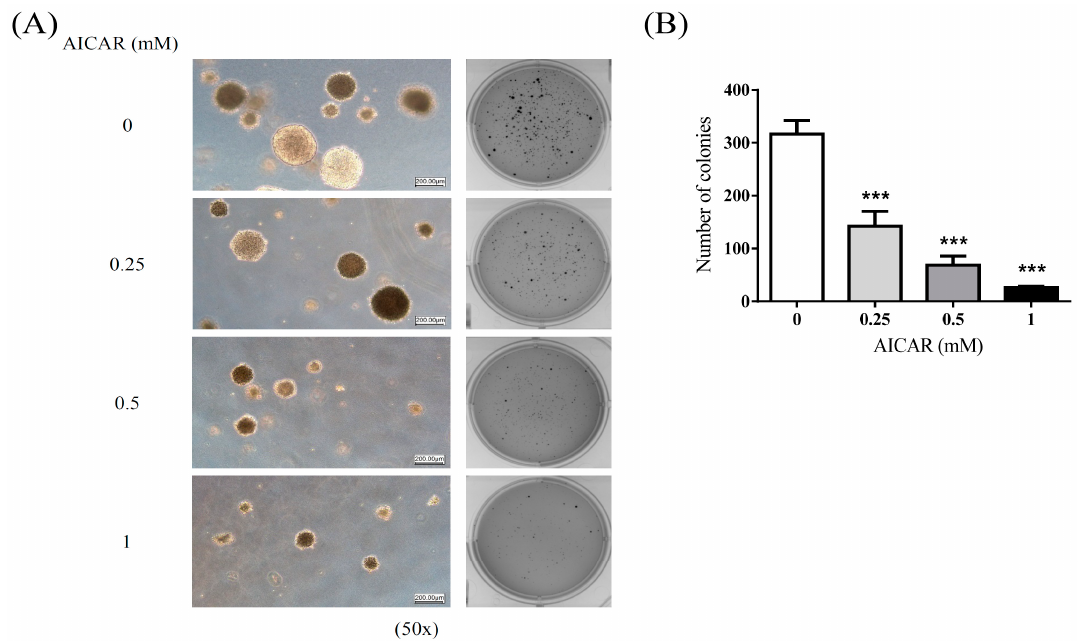
Figure 2. The effect of AICAR on growth under anchorage-independent conditions of prostate cancer cells. 22Rv1 cells were treated with different concentrations of AICAR, and then grown in soft agar, an anchorage-independent condition, for 3 weeks. ( A ) Colonies were stained with crystal violet and captured using the Bio-Rad ChemiDoc XRS+ system (Hercules, CA, USA). ( B ) Data are quantified and represented as means ± SD of triplicate values and statistical significance was determined using the Student’s t-test (*** p < 0.001).